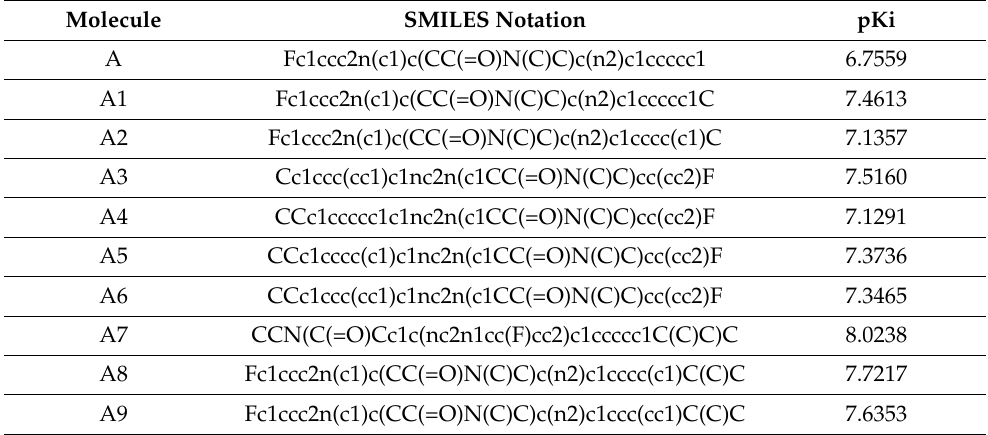
Table 3. The list of all designed molecules with their SMILES notation and calculated activities.